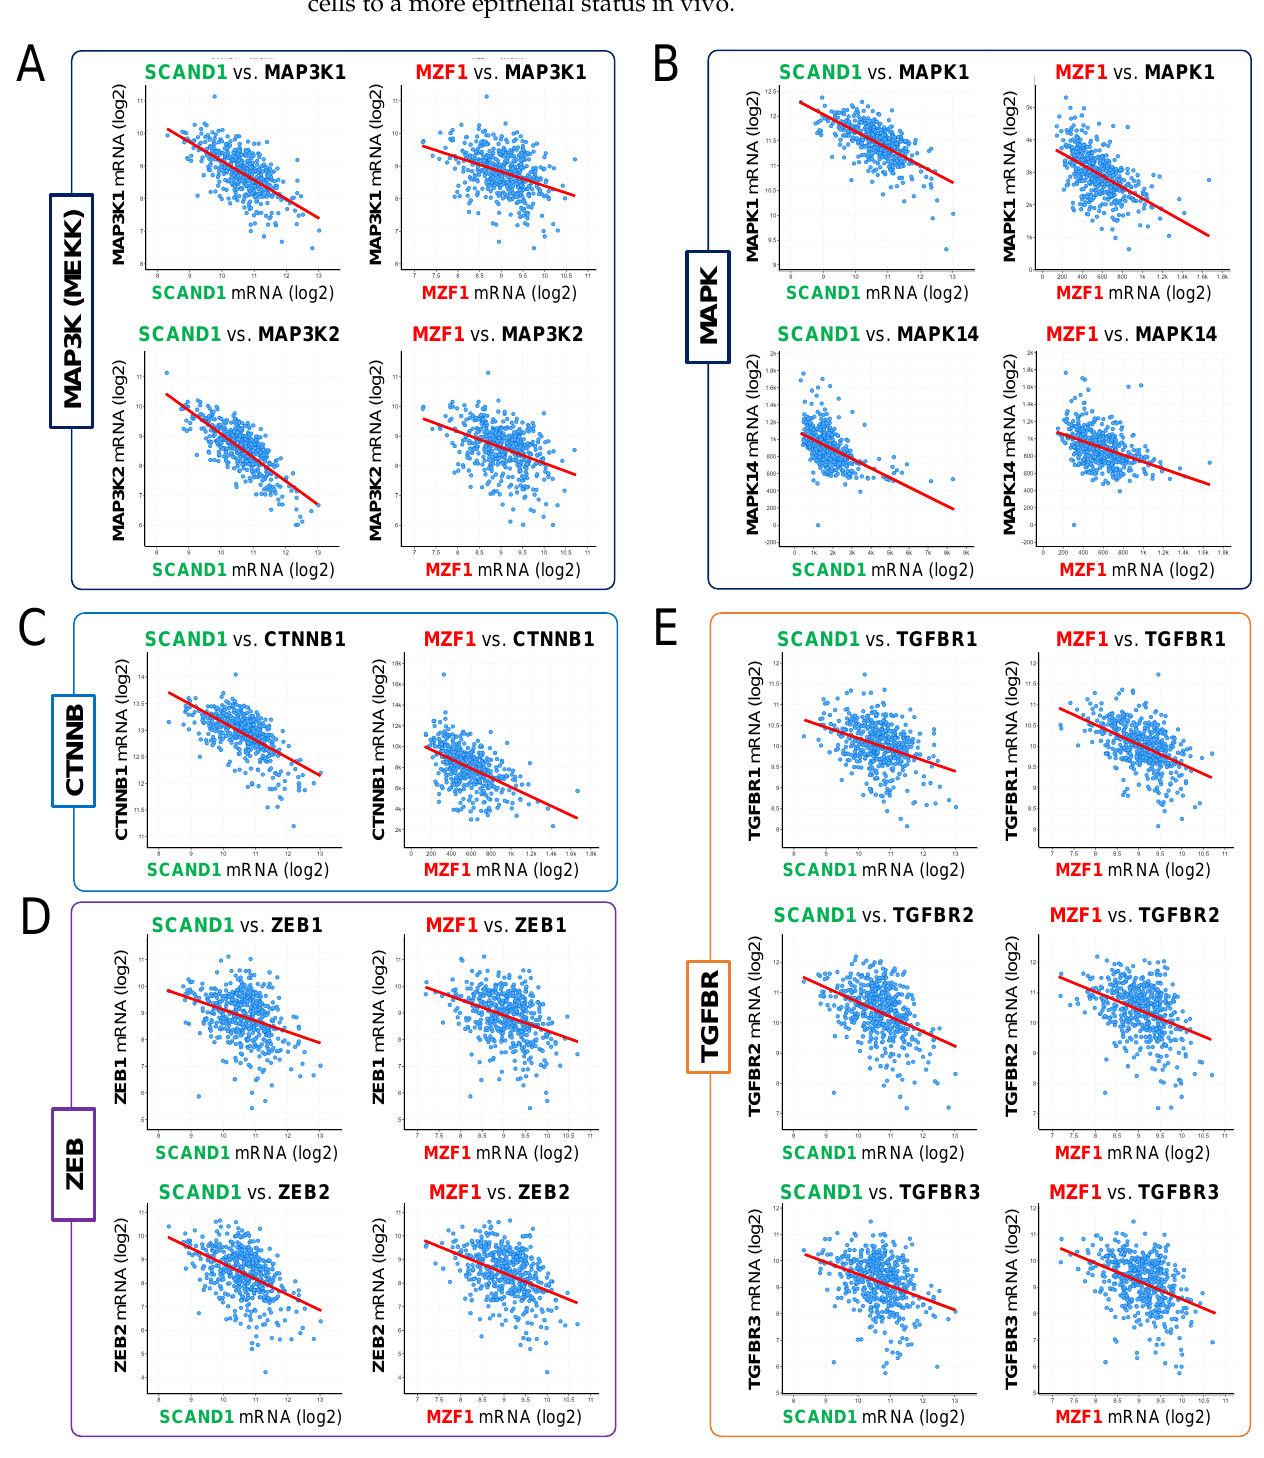
Figure 4. SCAND1 and MZF1 expression negatively correlated with gene expression of MAP3Ks (MEKKs), MAPKs, and EMT drivers in prostate tumors. We analyzed the co-expression of SCAND1 and MZF1 vs. ( A ) MAP3K1 (MEKK1) and MAP3K2 (MEKK2), ( B ) MAPK1 (ERK2) and MAPK14 (p38Alpha), ( C ) CTNNB1 (encoding β -catenin), ( D ) ZEB1 and ZEB2, and ( E ) TGF β receptors (TGFBR1, TGFBR2, and TGFBR3) in patients-derived prostate adenocarcinoma